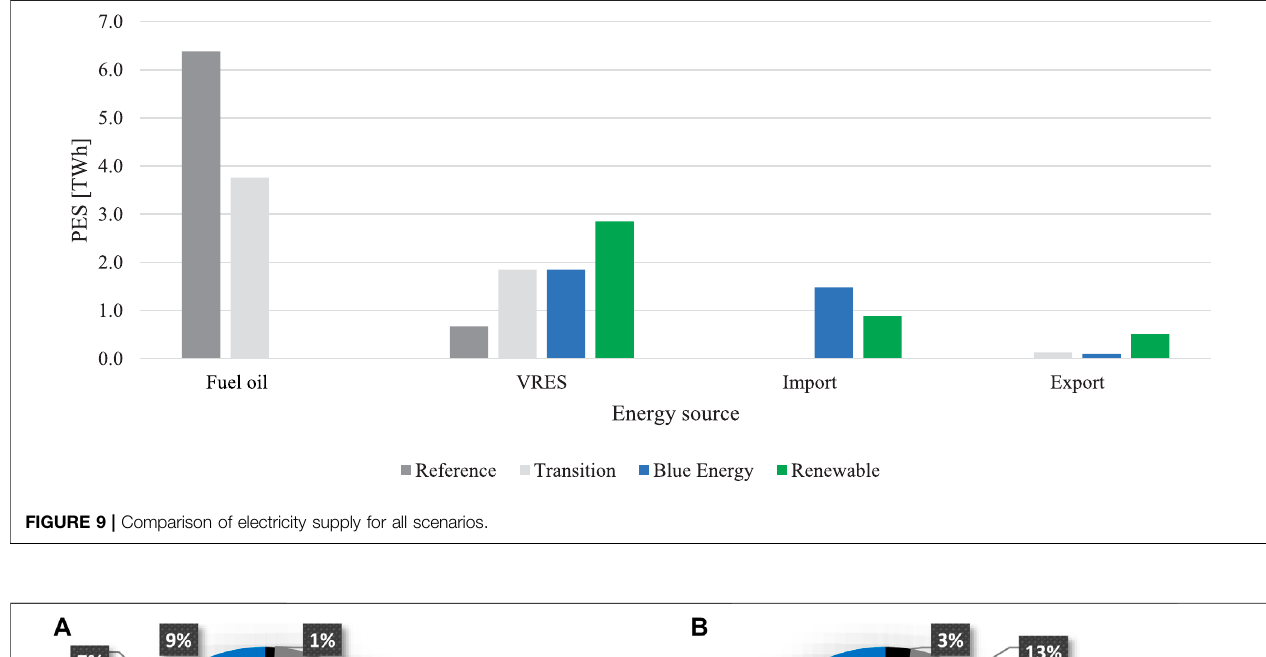
FIGURE 9 | Comparison of electricity supply for all scenarios.